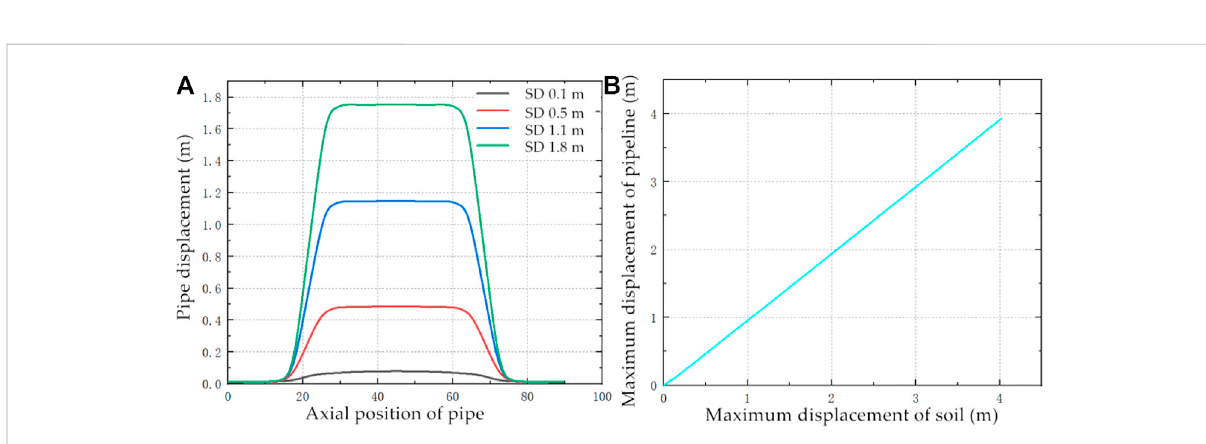
Relationship between pipeline displacement and landslide soil displacement (SD): (A) displacement at different positions along the pipeline, (B) maximum displacement of the pipeline.